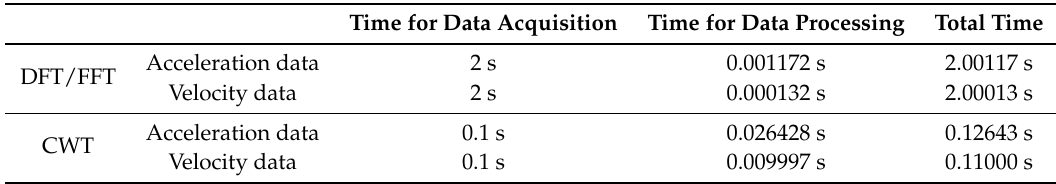
Table 2. Comparison of time performances for rub fault